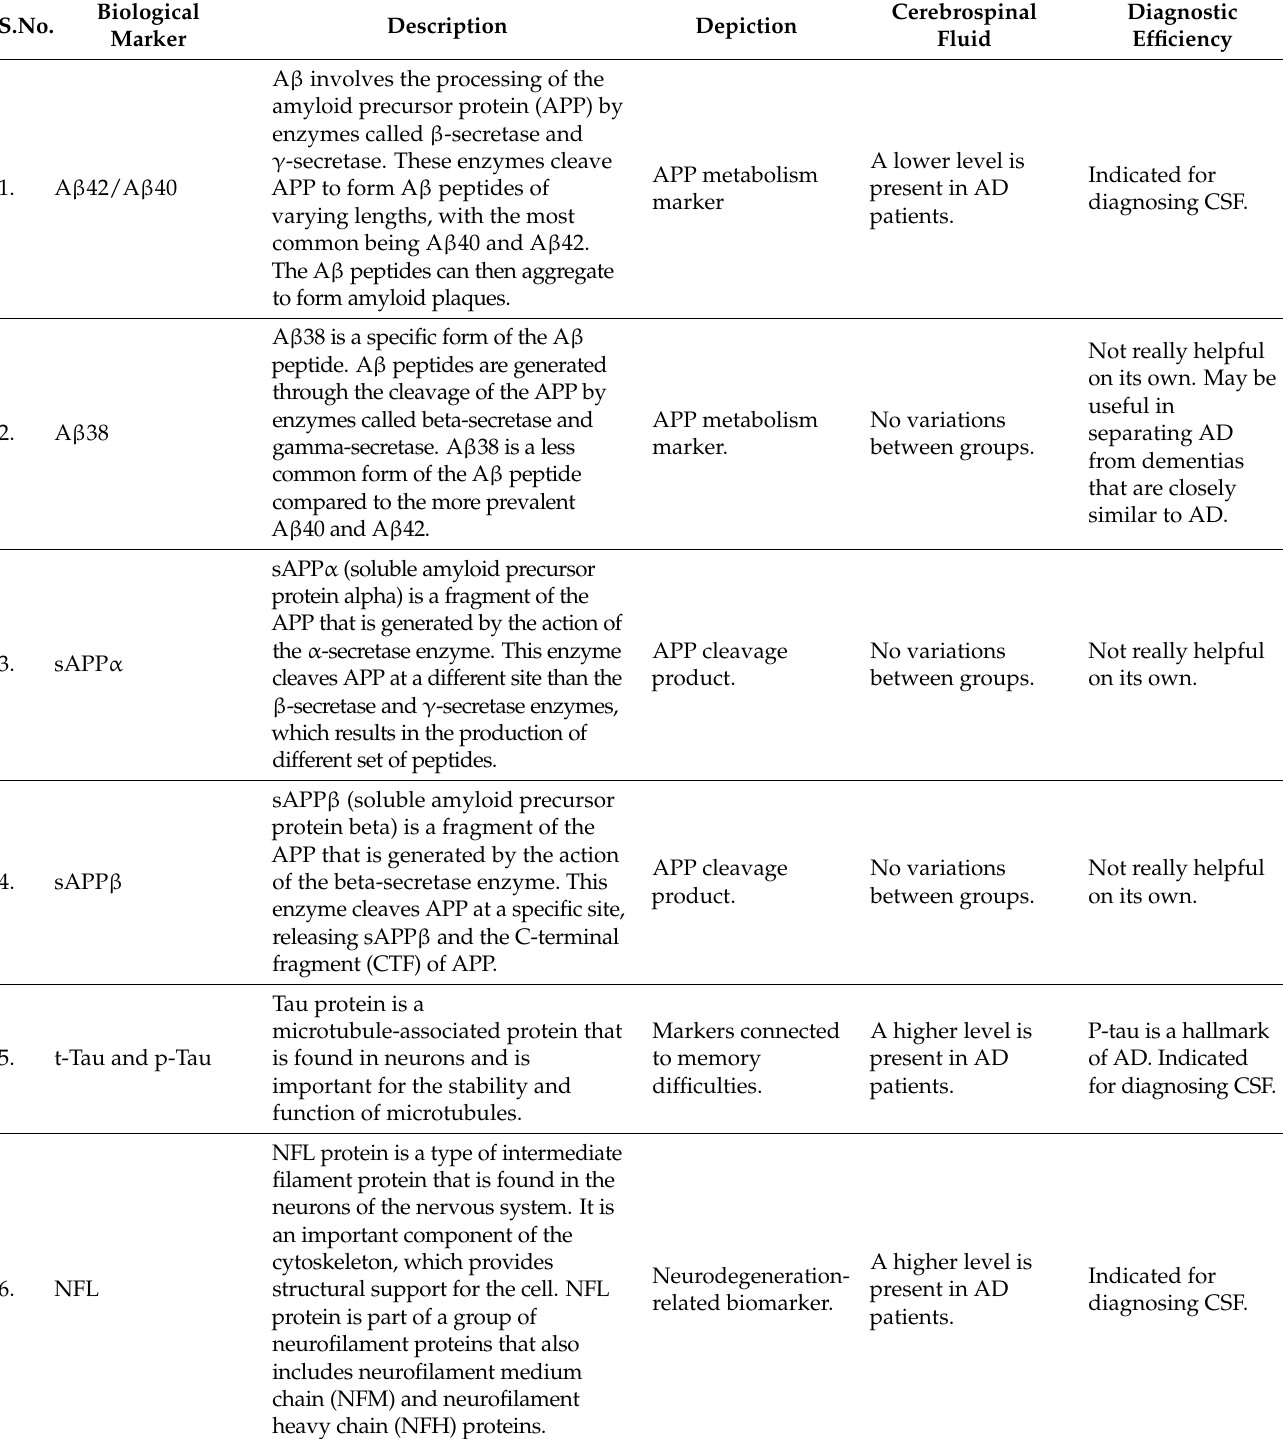
Table 1. AD Biomarkers. AD: Alzheimer’s disease; CSF: Cerebrospinal fluid; A β : Amyloid beta; APP: Amyloid precursor protein; NFL: Neurofilament light chain protein; NSE: neuron-specific enolase; VLP-1: Visinin-like protein 1; HFABP: Heart fatty acid binding protein; MCP-1: Monocyte